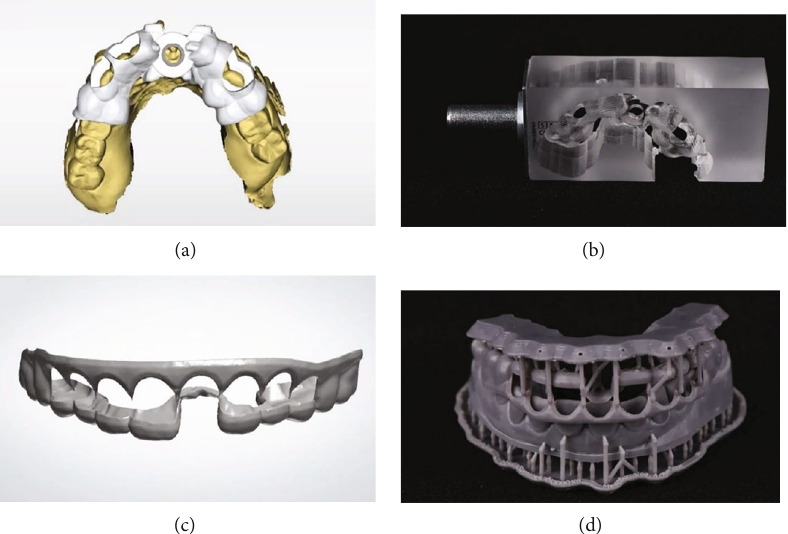
Figure 3: Design and fabrication of guides. Design of implant surgical guide in software (a), milled implant surgical guide (b), design of esthetic crown lengthening guide (c), and 3D printed esthetic crown lengthening guide